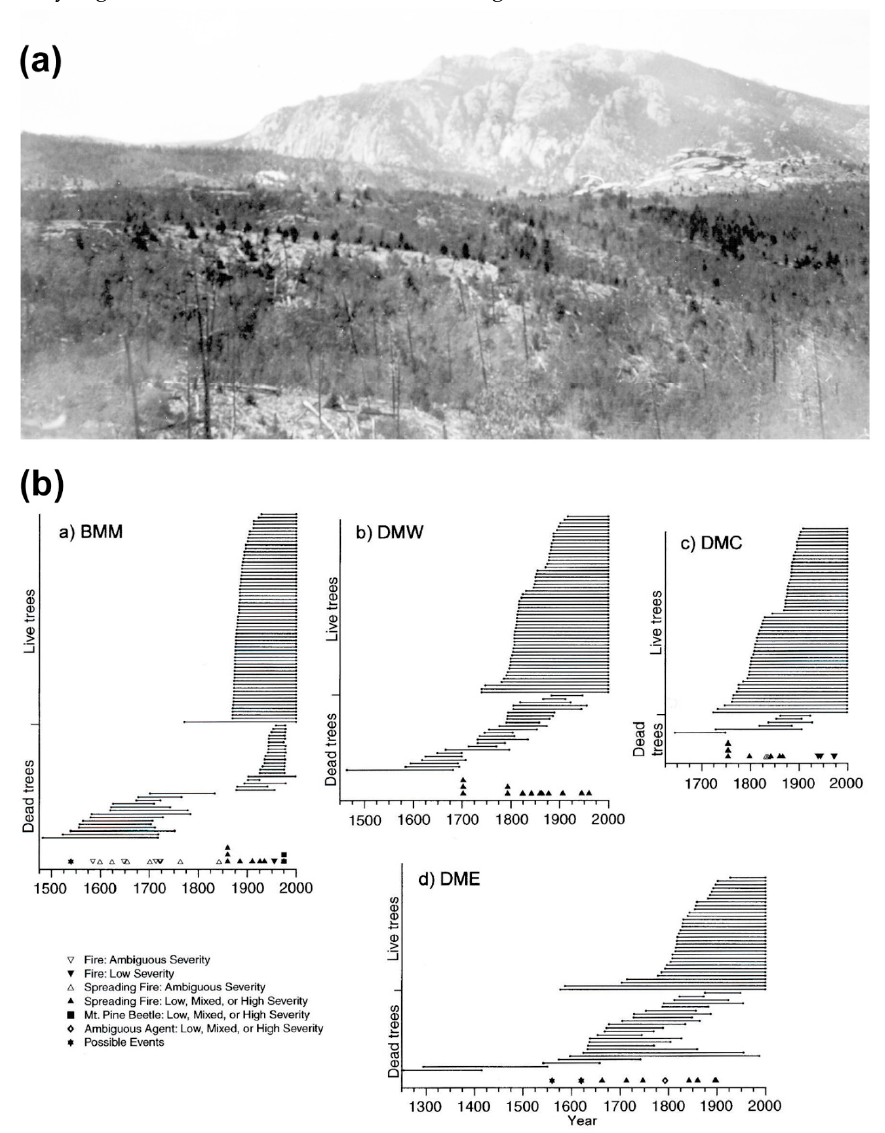
Figure 3. Two sources of evidence, early oblique photographs, and tree-ring reconstructions of age structure and fire scar dating of high-severity fires in dry forests in the Colorado Front Range: ( a ) high-severity fire identified by Jack [46] as in ponderosa pine and subsequent ponderosa pine (dark black) and quaking aspen regeneration in central Colorado in the Plum Creek Reserve; original photo, taken 18 August 1889, probably by John Jack, labeled “Looking north at Devils Head (Platte) Mt. from east side”. Original photo in the National Archives, FRA no. 008, ( b ) event diagram for four sample plots in which a tree-ring reconstruction of age structure of live and dead trees was completed in dry forests in Rocky Mountain National Park, Colorado. The severity of an event is indicated by the number of symbols stacked vertically: 1, low severity; 2, mixed severity; and 3, high severity. For example, in plot BMM, a high-severity fire was identified in the 1870s by a fire scar, extensive regeneration after the fire, and dead trees before the fire. Each line shows the lifespan of one tree. Reprinted from ([14] Figure 2) with permission from John Wiley and Sons.